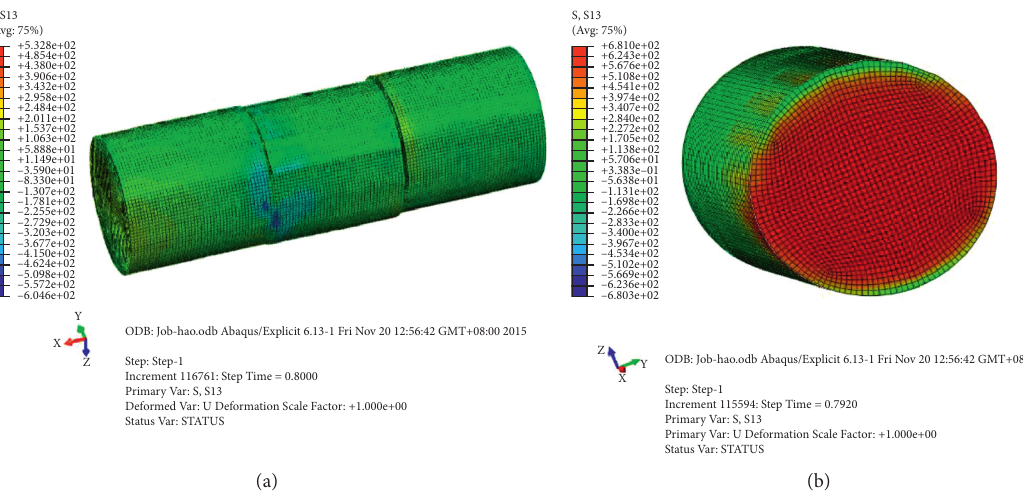
Figure 14: Material sample test, and stress contour at time of fracture. (a) Material sample contour. (b) Material sample cut contour.